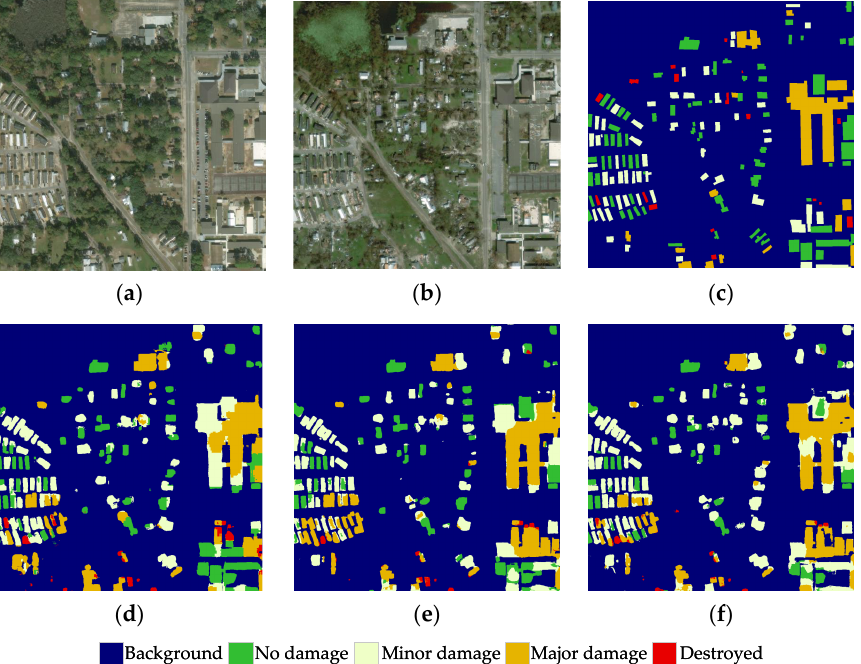
Figure 9. The visual comparison of prediction results on hurricane-Michael in xBD dataset. ( a ) Pre- disaster; ( b ) post-disaster; ( c ) ground truth; ( d ) baseline; ( e ) SDAFormer (without SF); ( f ) SDAFormer (with